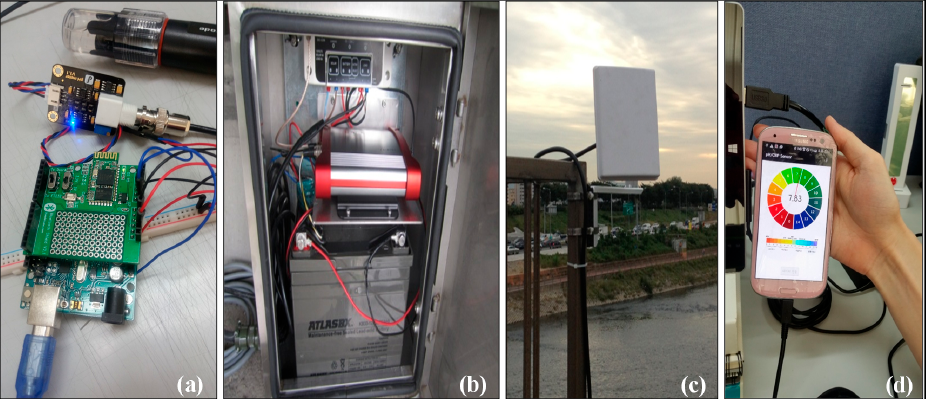
Figure 3. ( a ) Integrated Arduino-based Bluetooth shield pH sensor; ( b ) solar power-controlled battery (3 V to 5 V with 12 V to 24 V); ( c ) Bluetooth flat panel antenna (2.4 GHz with 15.5 dBi); and ( d ) Arduino-based mobile application for smartphones. Table 1. Summary statistics of seasonal variations in stream data obtained via the ASM framework.